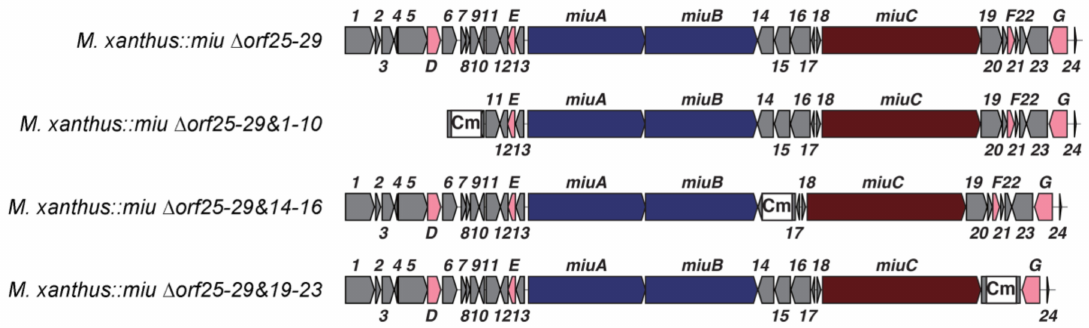
Figure 5. Gene organizations of miu clusters lacking multigene regions. Cm represents the chloram- phenicol resistance gene that was used as a selection